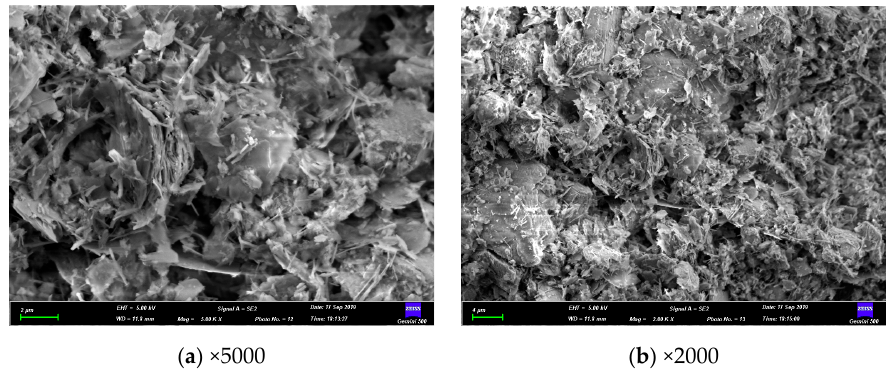
Figure 12. SEM images of CPB at different magnifications (20 °C and 3d).